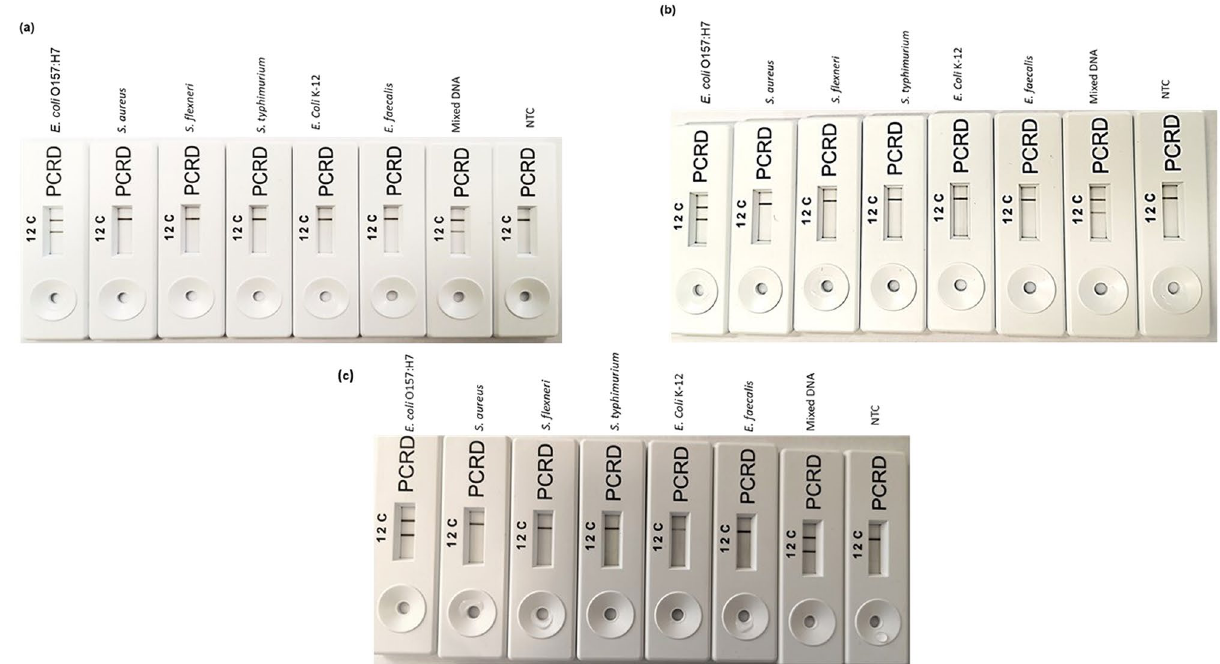
Figure 2. Validation of RPA-LFA for specificity. ( a ) Using the rfbE F1/R1 primer set ( b ) Using the fliC F2/R2 primer set, and, ( c ) Using the stx1 F2/R2 primer set. From left to right: Escherichia coli O157:H7, Staphylococcus aureus , Shigella flexneri , Salmonella thyphimurium , E. coli K-12, Enterococcus faecalis , mixed bacterial DNA, non-template control (NTC).